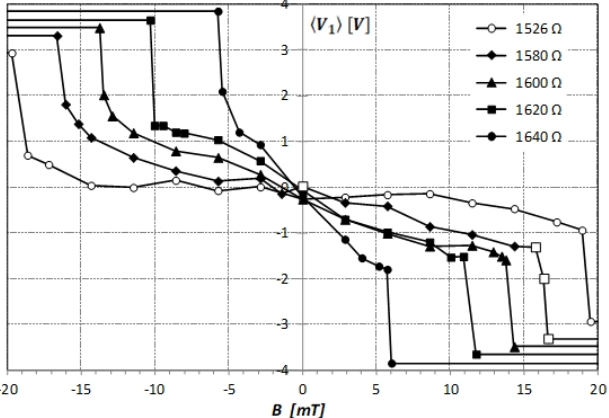
Figure 3. Experimental dependence of the average voltage (cid:104) V 1 ( t ) (cid:105) on the capacitor C 1 calculated in 10 s time window on the intensity of the static magnetic field for different R values given in the plot. Examples of V 1 ( t ) for points denoted by empty squares are shown in Figure 2.